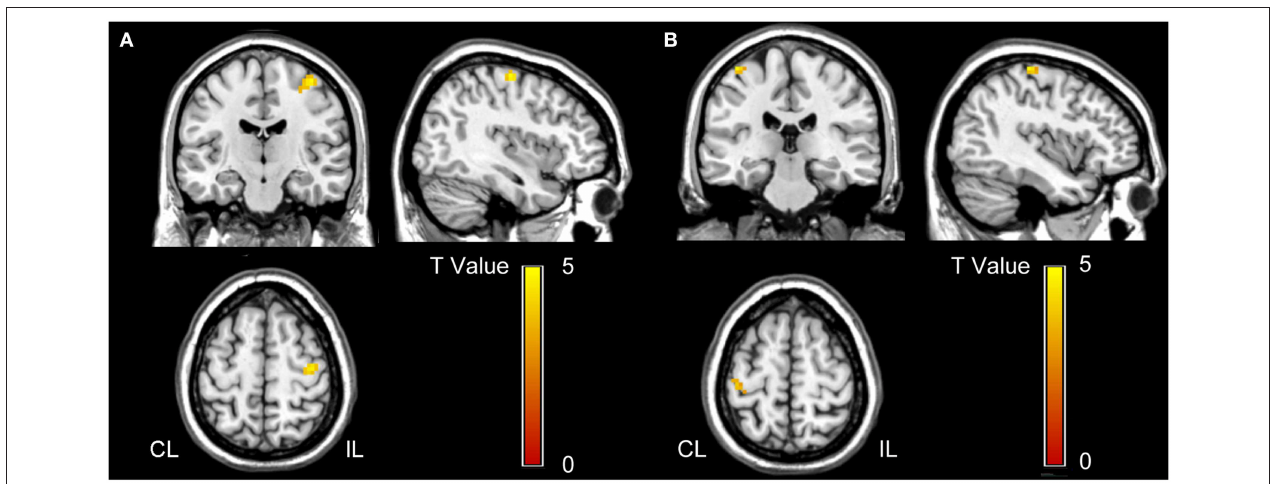
FIGURE 2 | Voxel-wise comparisons in task-evoked activation (A) and effective connectivity (B) between stroke patients and normal controls. (A) Stroke patients show increased activation in the ipsilesional M1 than normal controls ( P < 0.001, uncorrected). This cluster is used as the seed for the effective connectivity analysis. (B) Stroke patients demonstrate increased effective connectivity from ipsilesional to contralesional M1 than normal controls ( P < 0.05, FWE corrected). CL, contralesional; FWE, family wise error; IL, ipsilesional; and M1, primary motor cortex.